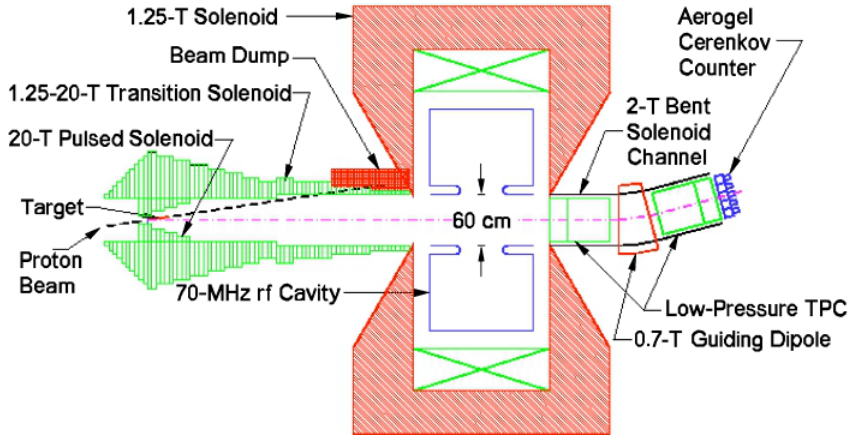
FIG. 22. (Color) Plan view of the full configuration of the targetry